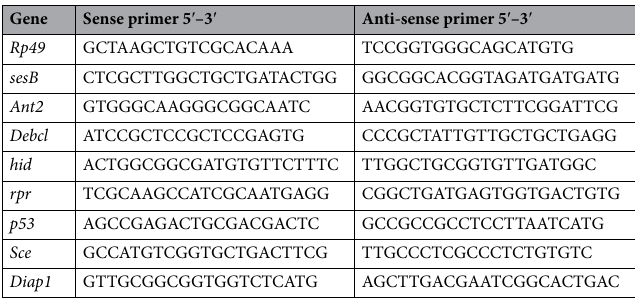
Table 1. Primers for real-time quantitative PCR amplification.